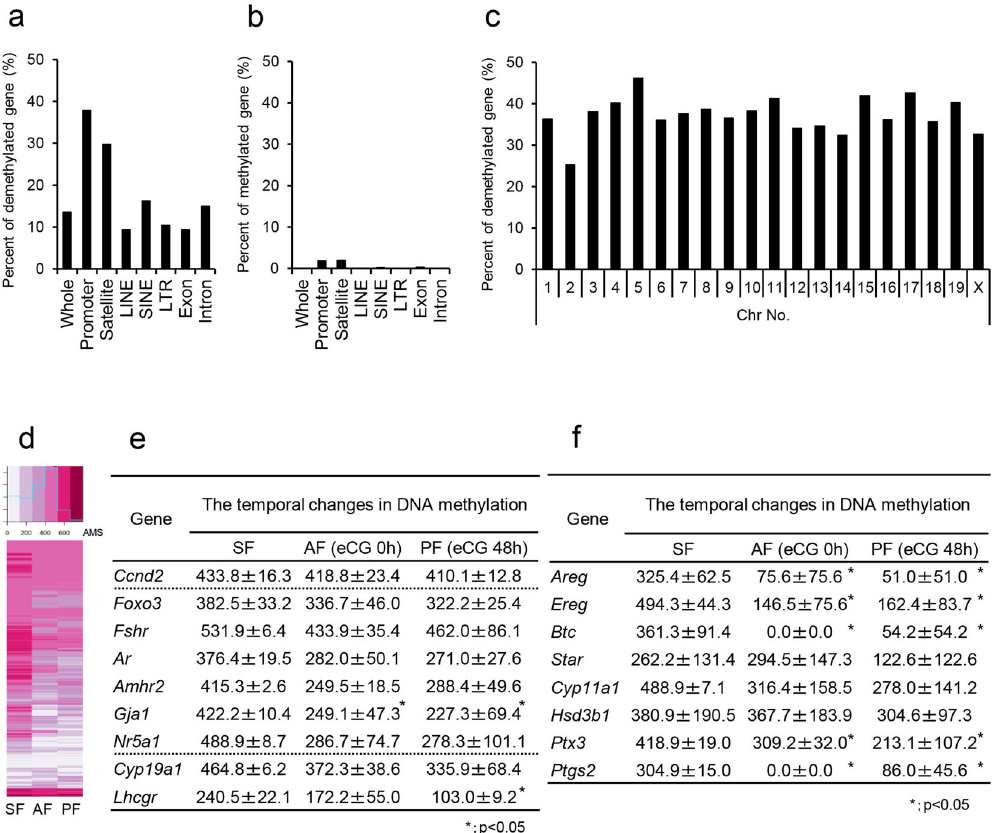
Fig. 3 Comprehensive analysis of genome-wide DNA methylation status in granulosa cells during follicular development. a , b The percentage of genes that were signi fi cantly demethylated ( a ) or methylated ( b ) during follicular development in each genomic region. c The percentage of signi fi cantly demethylated genes in promoter regions of each chromosome. d Clustering analysis of demethylated genes in promoter regions of granulosa cells during follicular development. SF, granulosa cells in secondary follicles with multilayered granulosa cells; AF, granulosa cells in antral follicles (3-week mice not treated with eCG); PF, granulosa cells in preovulatory follicles (at 48 h after eCG injection). e , f Temporal changes in DNA methylation of marker genes ( e ) and LH-targeting genes ( f ) in granulosa cells during the follicle development process. The values are represented as the mean ± SEM ( n = 3 biological replicates). The mean ± SEM values from MeDIP-seq analysis are absolute methylation signals (AMS) in speci fi c promoter regions containing CpG sites. For genes with multiple speci fi c promoter regions, including CpG sites, the average value was calculated. The signi fi cant differences between values in antral follicles (3-week mice not treated with eCG) or preovulatory follicles (at 48 h after eCG injection) and that in granulosa cells of secondary follicles (SF) were analyzed ( p <